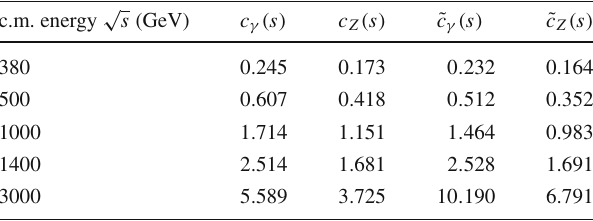
Table 3 The values of the coefficients in the expressions for the asym- metries A Re and A Im . The values are calculated for several c.m. ener- giesusedinthispaperandforthe e − ( P e − = − 1, P e + = + 1)